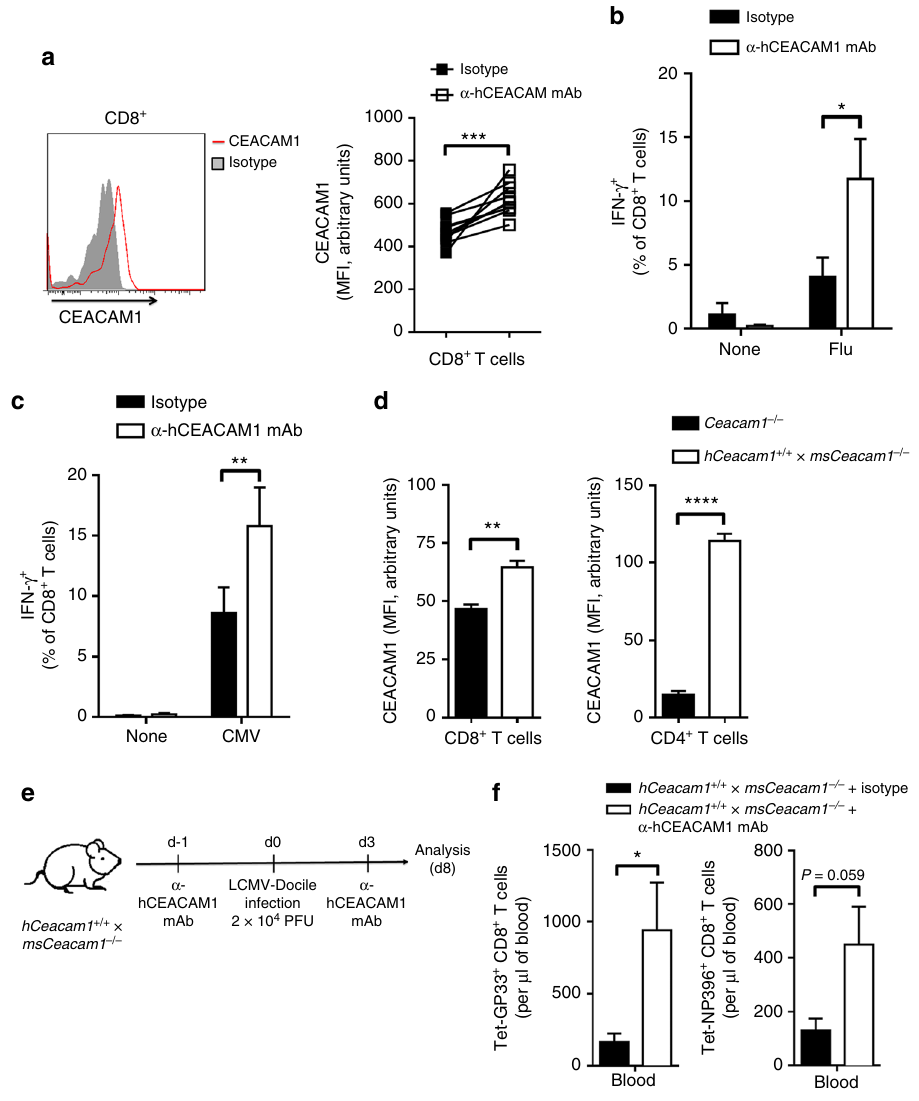
Fig. 6 Treatment with anti-hCEACAM1 mAb improves CD8 + T cell function in human cells. a Representative fl uorescence-activated cell sorting (FACS) histogram (left panel) showing CEACAM1 expression and mean fl uorescence intensity (MFI) levels (right panel) of naïve CD8 + T cells from the peripheral blood of healthy donors ( n = 10). b , c Intracellular cytokine (interferon- γ (IFN- γ )) secretion by peripheral blood mononuclear cells (PBMCs) from healthy donors that were cultured with Flu peptide together with anti-CD28 antibody ( b ) or with or without cytomegalovirus (CMV) peptide ( c ) and human interleukin-2 (IL-2) in the presence or absence of anti-hCEACAM1 antibody (40 µ g ml – 1 ; clone 18/20) for 10 days. Cytokine production was assessed by restimulation of PBMCs with or without Flu peptide ( b , n = 8 – 10 per group) for 6 h or with CMV peptide ( c ; n = 9 per group) for 8 h at 37 °C, as measured with fl ow cytometry. d Histogram showing mean fl uorescence intensity (MFI) levels of CEACAM1 expression in peripheral blood CD8 + (left panel) and CD4 + (right panel) T cells from hCeacam1 + / + × msCeacam1 – / – mice as measured by fl ow cytometry ( n = 4 – 5 per group). e Experimental setup. Human CEACAM1 transgenic mice ( hCeacam1 + / + × msCeacam1 – / – ) were injected with anti-hCEACAM1 antibody (clone 18/20) or isotype antibody on day – 1 (100 µ g/mouse) and day 3 (200 µ g/mouse), followed by infection with 2 × 10 4 PFU of LCMV-Docile on day 0. f Number of virus-speci fi c Tet-GP33 + (left panel) and NP396 + (right panel) CD8 + T cells in blood from hCeacam1 + / + × msCeacam1 – / – mice on day 8 after infection ( n = 5 per group). * P < 0.05, ** P